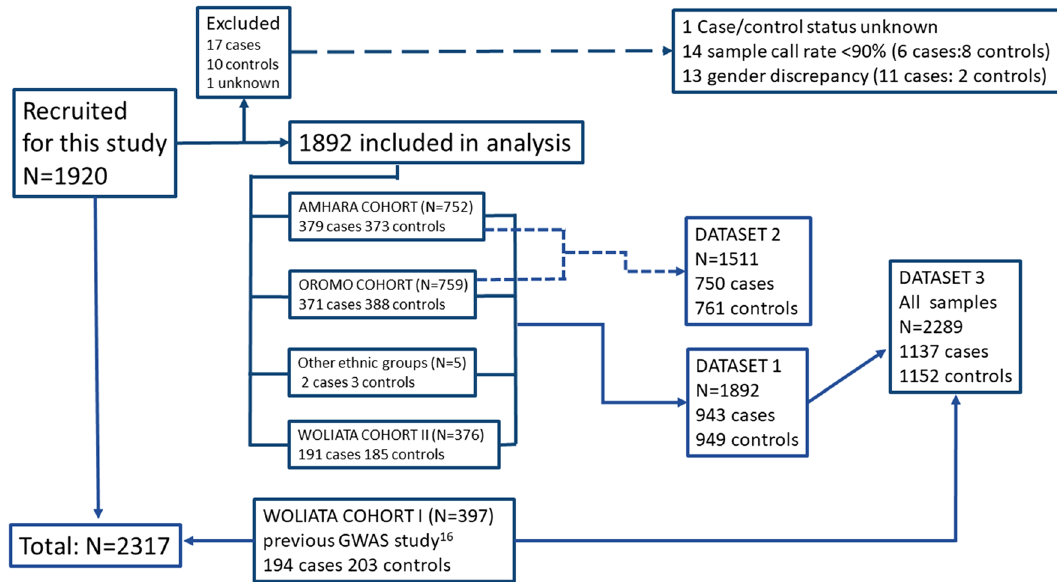
Figure 1. An overview of recruitment numbers and data analysis strategy. A total of 2317 DNA samples were available comprising 1920 new samples from three different Ethiopian ethnic groups (Amhara, Oromo and Wolaita) and 397 samples from a previous GWAS study on podoconiosis undertaken in a different cohort from the Wolaita group 16 . Twenty-eight new samples were excluded following QC checks. Data were analysed in three sets: dataset 1 comprised all newly recruited individuals from the three ethnic groups; dataset 2 comprised dataset 1 minus the Wolaita II cohort and ‘other ethnic groups’ samples; and dataset 3 comprised the total samples available for analysis from all